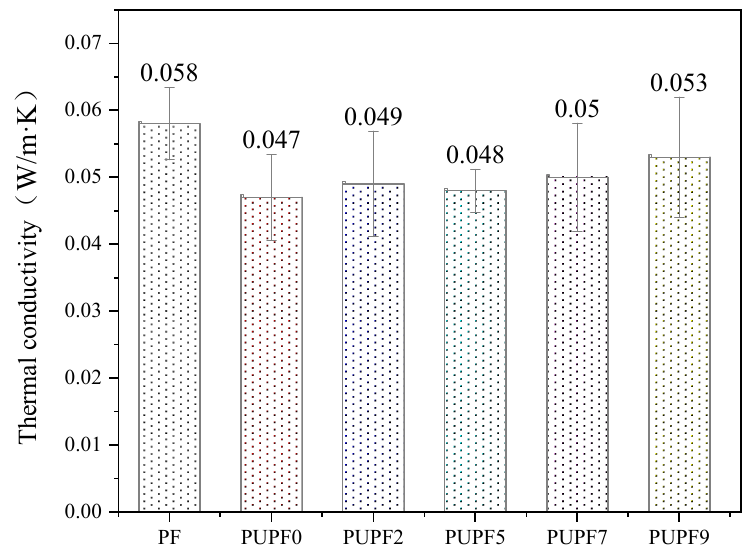
Figure 9. Thermal conductivity of PF and PUPFs.